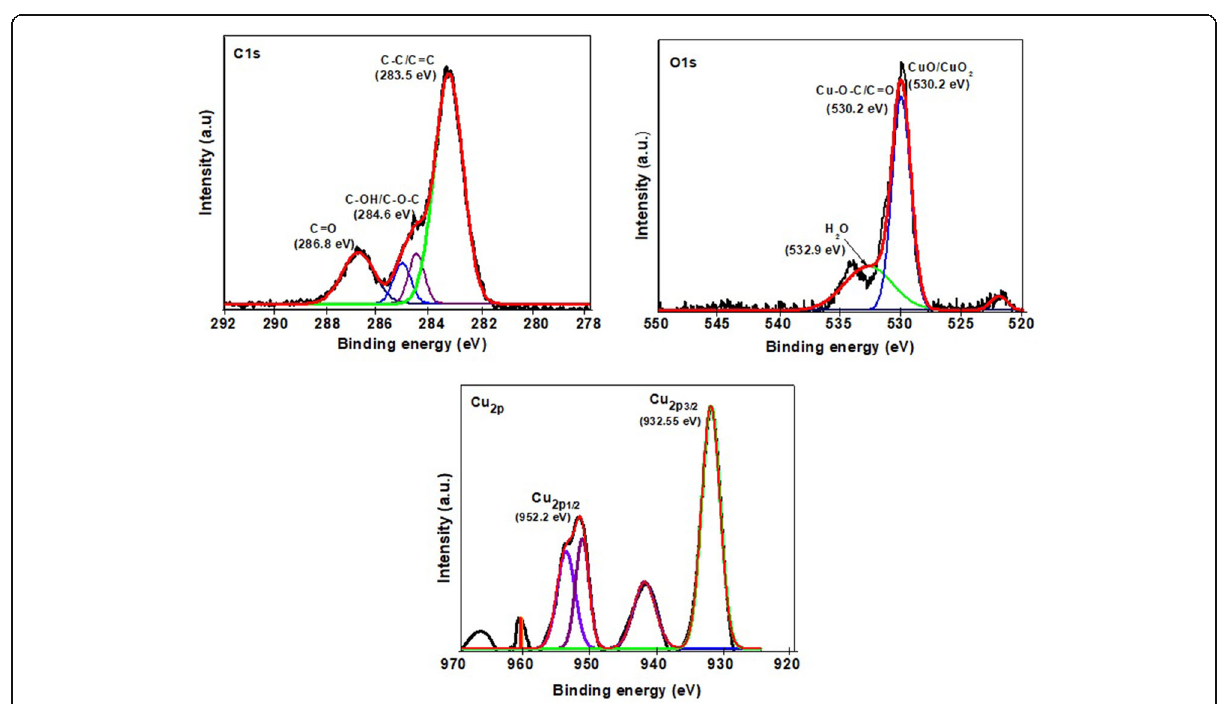
Fig. 8 Deconvoluted spectrum of GO/CuO a C1s, b O1s, and c Cu2p